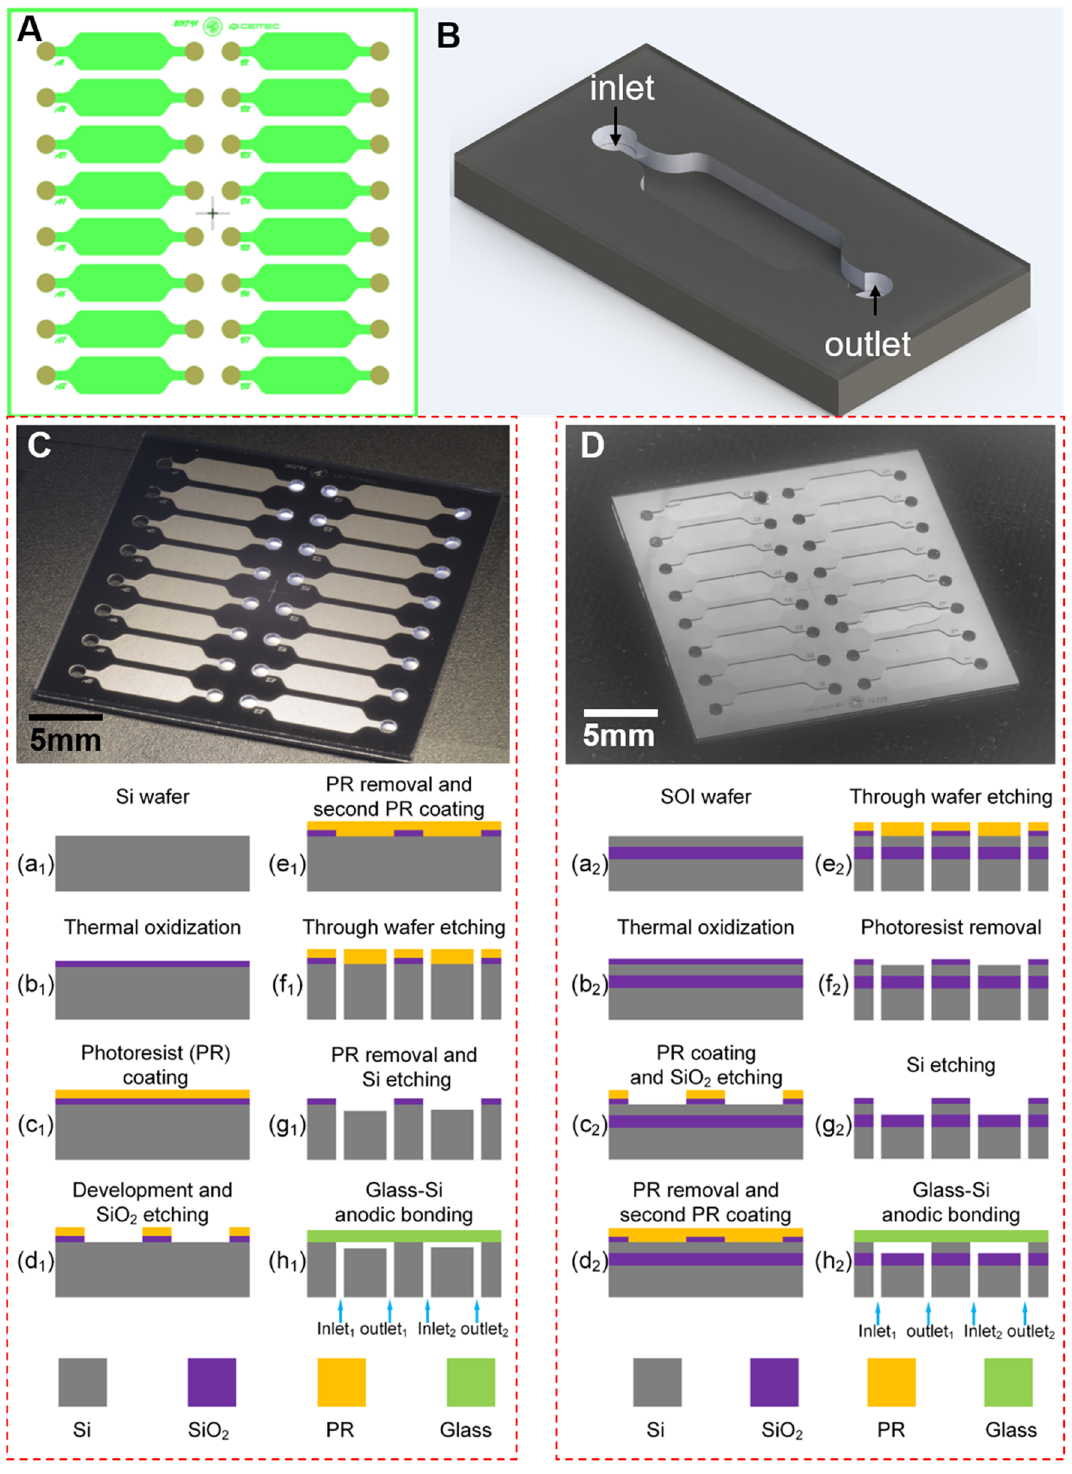
Figure 3. Description of the microfabrication processes based on different surface. ( A ) Layout of the chip with individual chamber for fluorescence measurement and ( B ) its visualization using computer-aided software. ( C ) Chip fabricated using conventional Si and ( D ) SOI